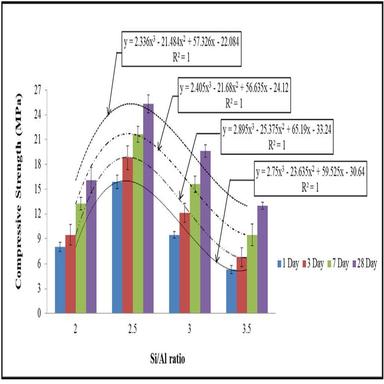
Coefficient of determination (R2 ) for effect of Si/Al ratio on 1, 3, 7 and 28 day compressive strength.